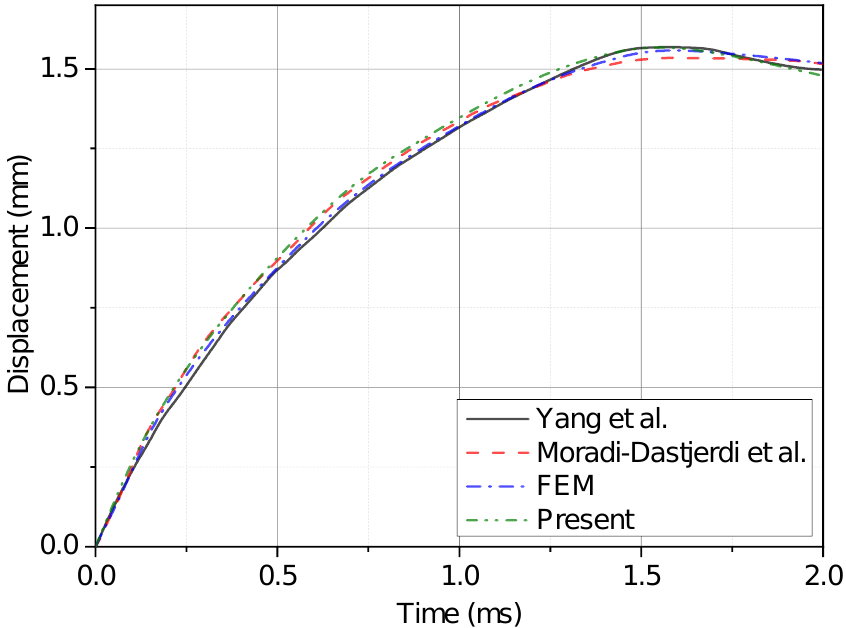
Figure 5. Comparison of the plate center displacement with the results obtained from the Ref. [38,86] and FEM method.